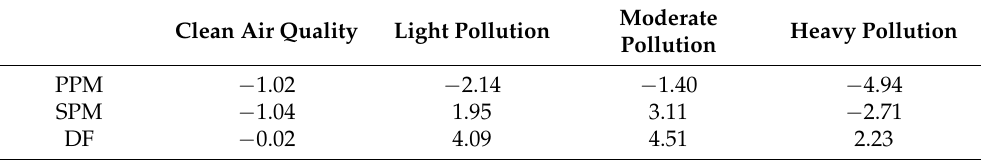
Table 4. Linear trends ( µ g · m − 3 · a − 1 ) of PPM and SPM with their differences (DF) in different air quality levels over 2015–2020. Clean Air Quality Light Pollution